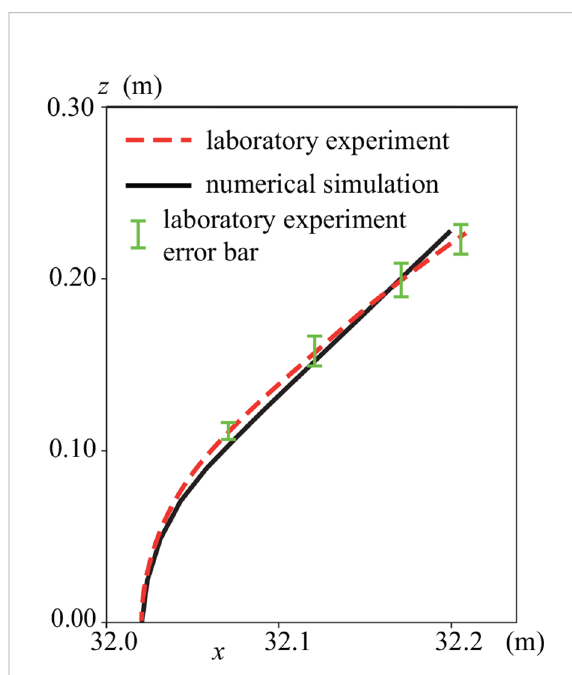
FIGURE 8 Blade shapes oflaboratory experiments and numerical simulations. Black solid and red broken linesare the model predictions and measured postures. Vertical green bars indicate the error bar, which was calculated by averaging the results ofthe three experiments.